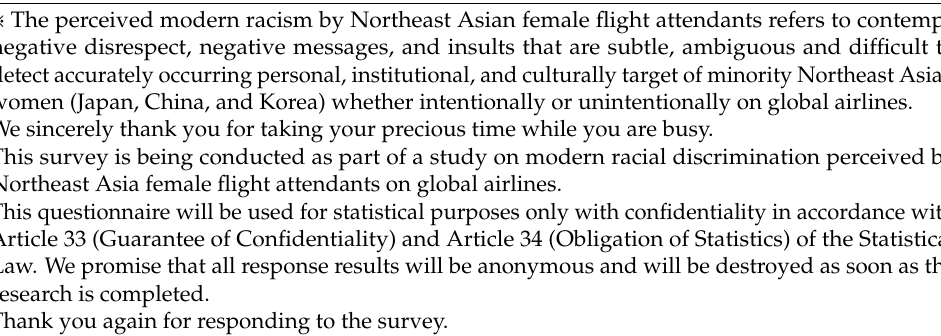
Table A1. Please mark (√) the number that matches your opinion. ( ➀ Strongly disagree ➁ disa- gree ➂ Neutral ➃ agree ➄ Strongly